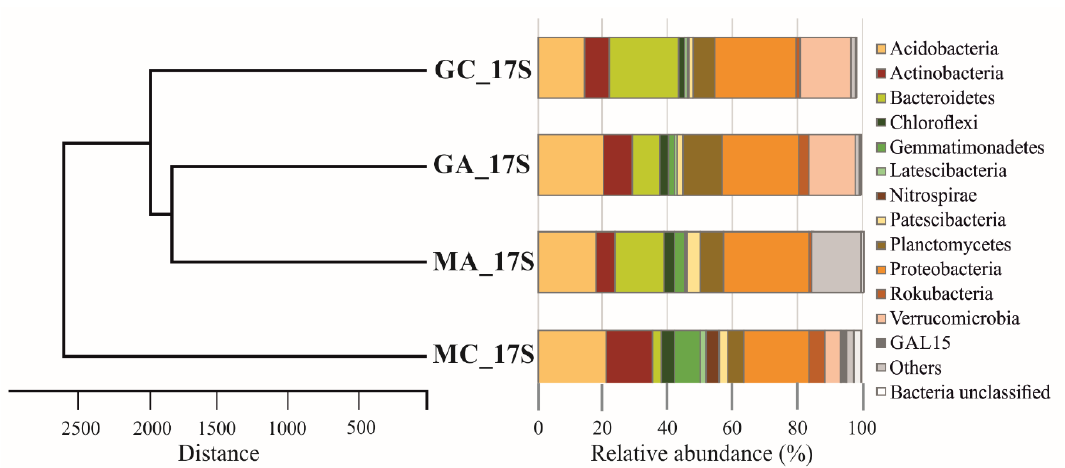
Figure 3. Relative abundance of bacterial phyla with a minimum abundance of 1% and the unweighted pair group method with arithmetic mean (UPGMA) similarity dendrogram of the maize monoculture and grassland soil samples based on the Bray–Curtis similarity index. (Sample signs are in Table 1.)